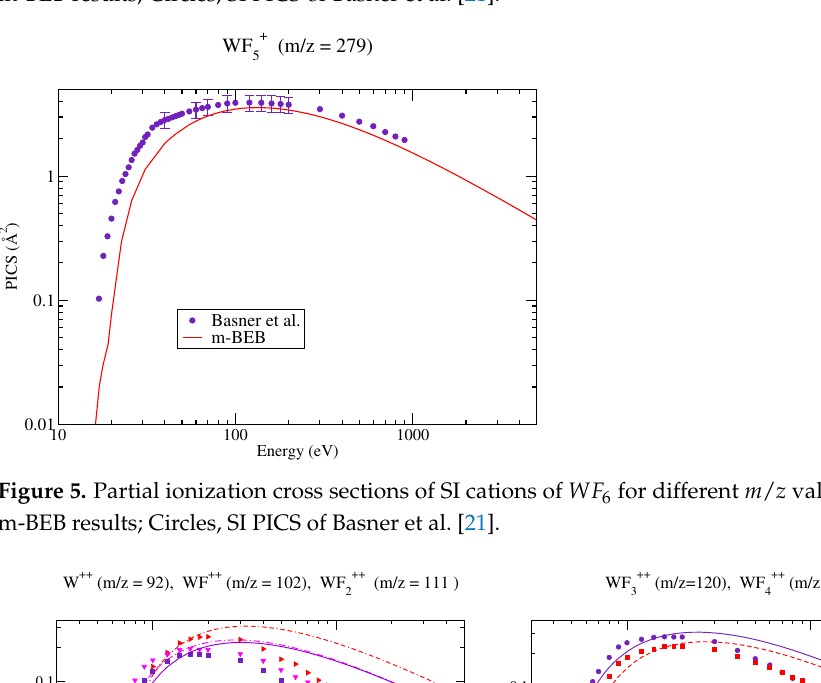
Figure 4. Partial ionization cross sections of SI cations of WF 6 for different m / z values. Line curve, m-BEB results; Circles, SI PICS of Basner et al. [21].